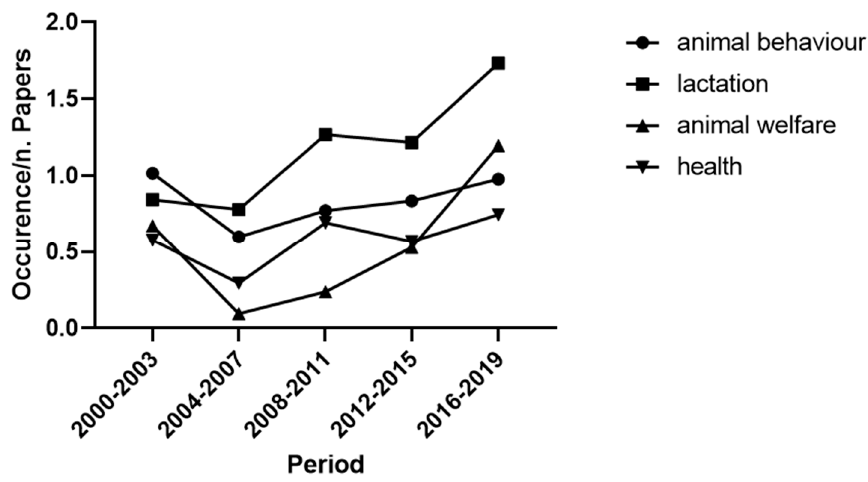
Figure 4. Papers: course of the most representative subjects of cluster “Animal” from 2000 to 2019.